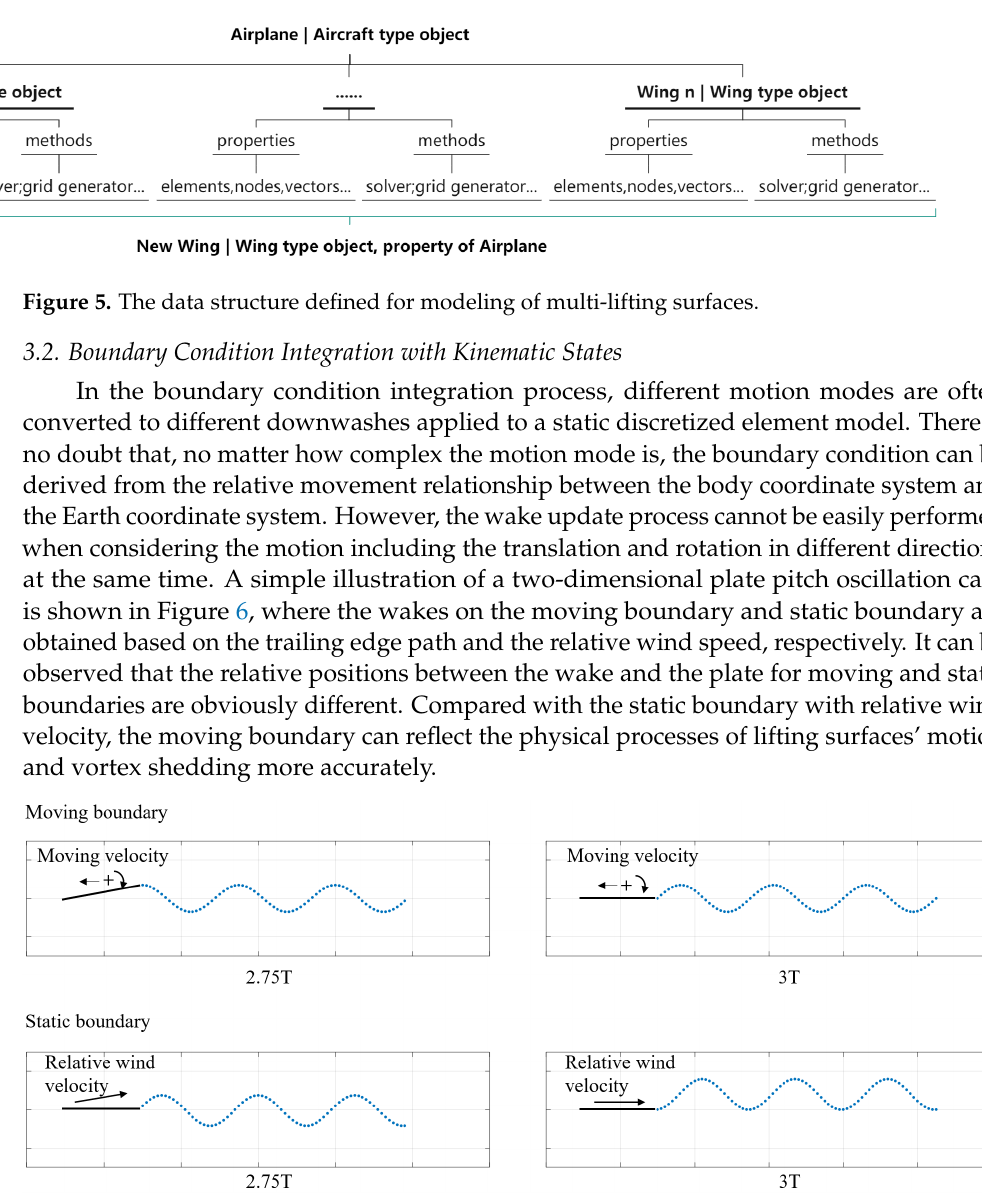
Figure 6. Comparison of moving and static